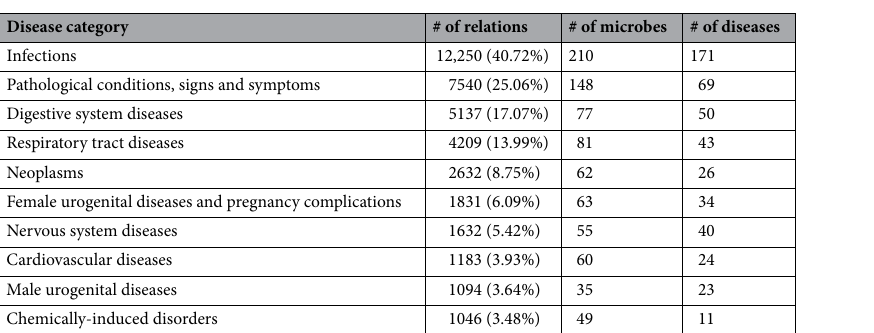
Table 3. Number of microbe-disease relations clustered by MeSH disease categories.